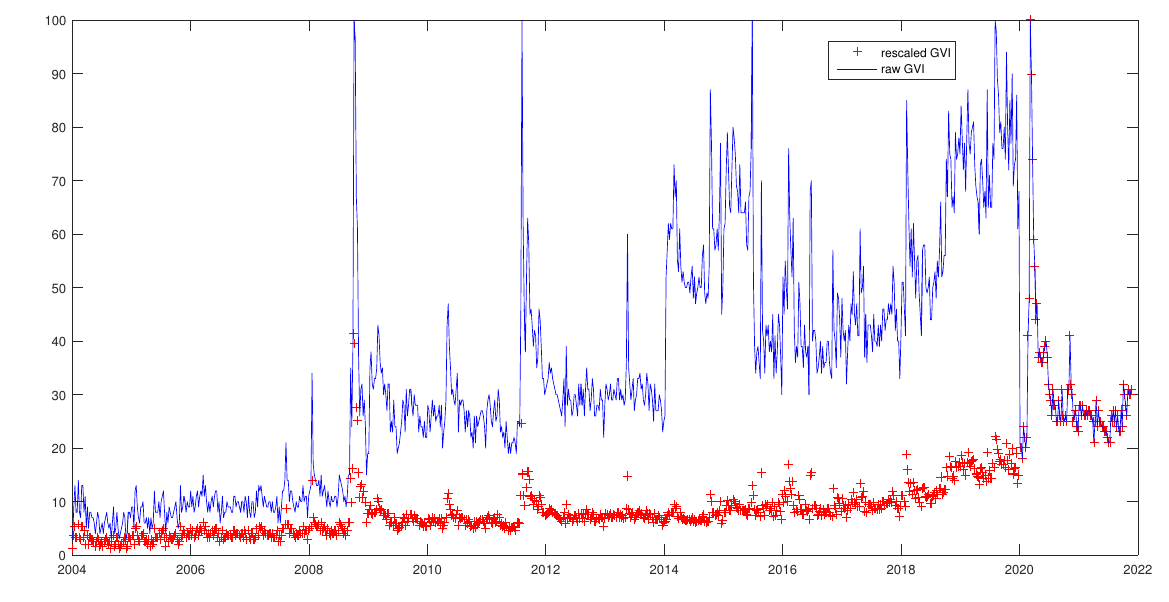
Figure A1. Raw and rescaled GVI for query